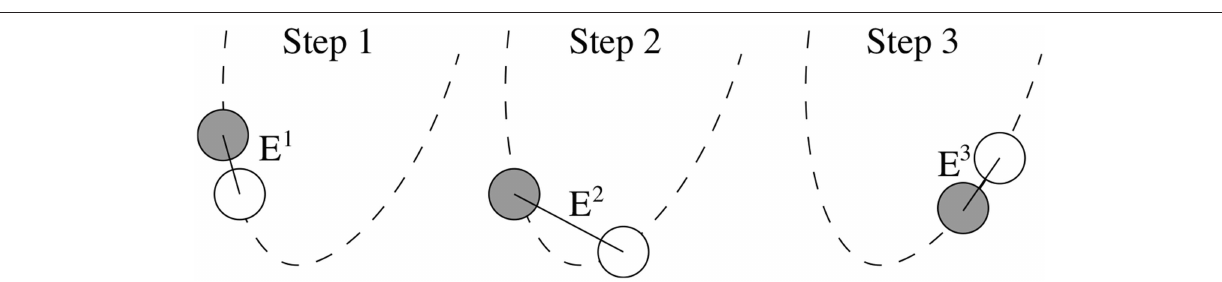
for some constant τ and free-body i . In this figure, free-body is denoted by the gray circle, and the exact